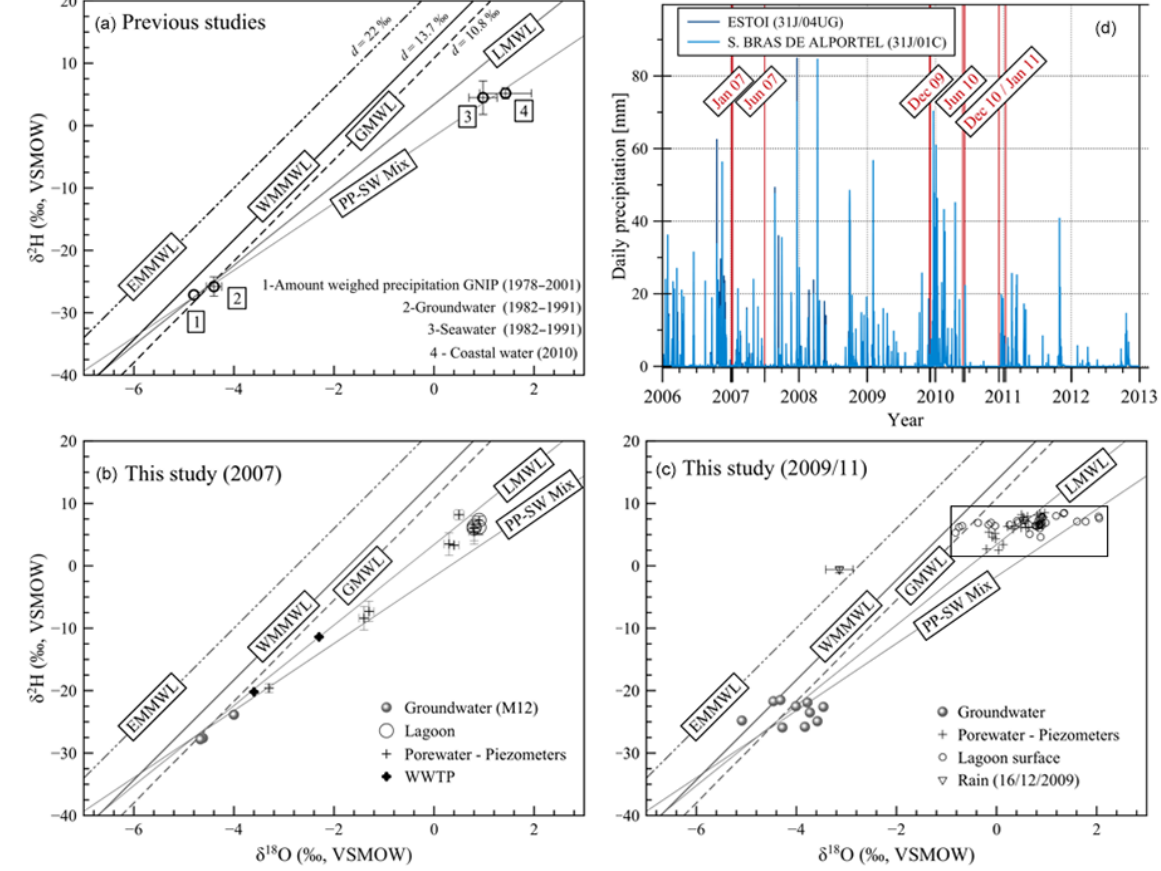
Figure 4. Catchment isotope hydrology. Counterclockwise, from top left: (a) shows the main meteoric water lines framing the isotopic composition of precipitation within the catchment, including the precipitation–seawater mixing line (PP-SW Mix, Sect. 4.2.1). (b) plots the isotopic compositional range of water samples taken during 2007, while (c) plots the isotopic compositional range of water samples taken during the period 2009–2011; the lagoon surface water samples (inset) are shown in more detail in Fig. 6. (d) provides the complete record of daily precipitation over the region for the period 2006–2013 for contextual support (see also Table 2 for summarized data). EMMWL: Eastern Mediterranean Meteoric Water Line (Gat and Carmi, 1970); WMMWL: Western Mediterranean Meteoric Water Line (Celle-Jeanton et al., 2001); GMWL: Global Meteoric Water Line (Clark and Fritz, 1997); LMWL: Local Meteoric Water Line (Carreira et al.,